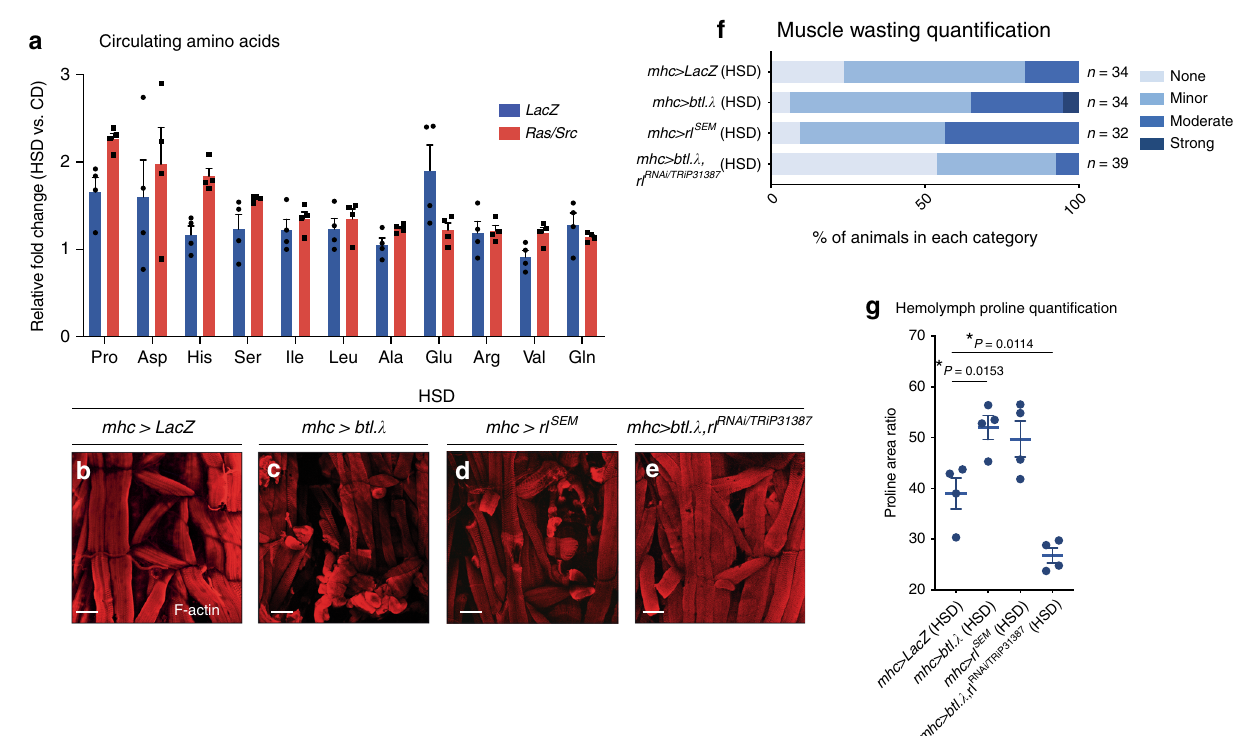
Fig. 3 Muscle-speci fi c Btl-dERK signalling promotes muscle wasting in HSD. a Circulating haemolymph levels of upregulated amino acids in LacZ (blue bars) and ras1 G12V ;csk − / − (red bars) animals raised on HSD compared to animals raised on CD. Results are shown as mean ± SEM. Data from n = 4 biologically independent samples. F-actin (red) staining of dissected larval body-wall muscle tissue from mhc > LacZ ( b ), mhc > btl. λ ( c ), mhc > rl SEM ( d ), and mhc > btl. λ , rl RNAi/TRiP31387 ( e ) third-instar larvae raised on HSD. Scale bar, 100 μ m. f Matching body-wall muscle wasting quanti fi cation. g Matching haemolymph proline quanti fi cation. Results are shown as mean ± SEM. Data from n = 4 biologically independent samples. Data were analysed by two- tailed unpaired Student ’ s t test. Asterisks indicate statistically signi fi cant difference (* P <